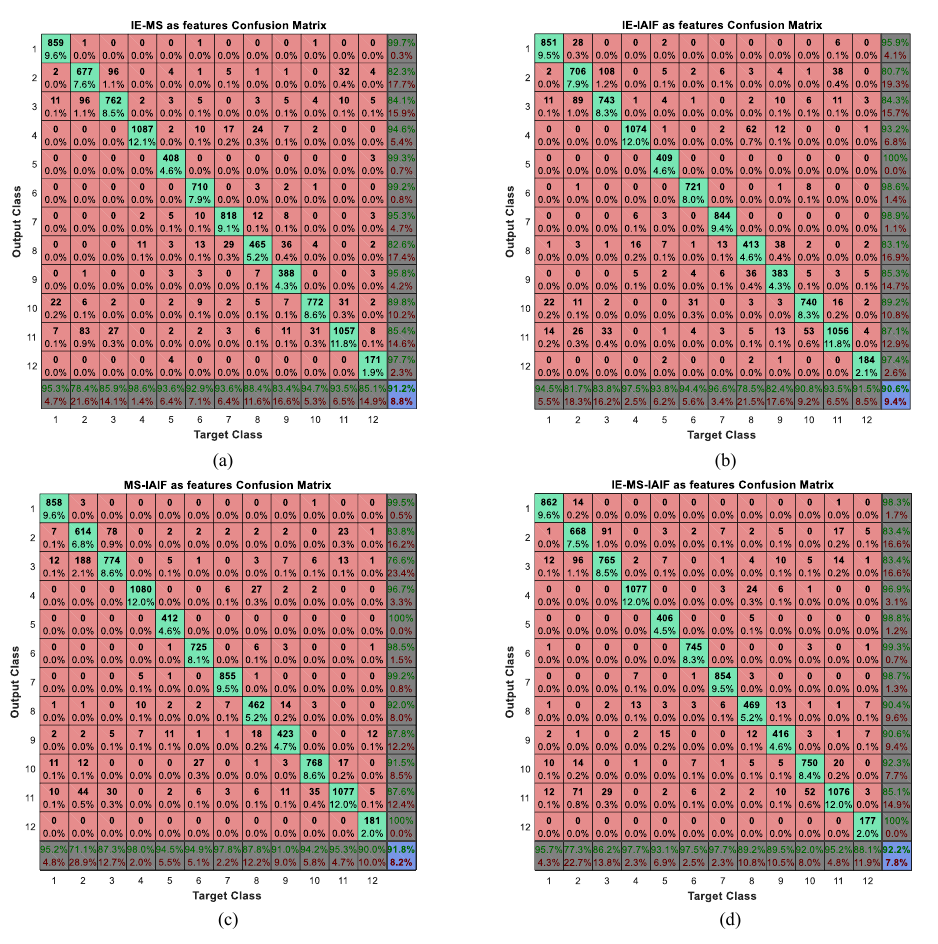
Figure 11. Confusion matrices of multi-features combinations. ( a ) IE and MS as features; ( b ) IE and IA-IF as features; ( c ) MS and IA-IF as features; ( d ) IE, MS, and IA-IF as features. The diagonal cells (green cells) show the number and percentage of correct classification. The red cells show where the classifier has made mistakes. The dark cells in the bottom row show the accuracy of each annotated class, while the dark cells in the right column show the accuracy of each recognized class. The purple cell in the bottom right of the matrix shows the overall accuracy.